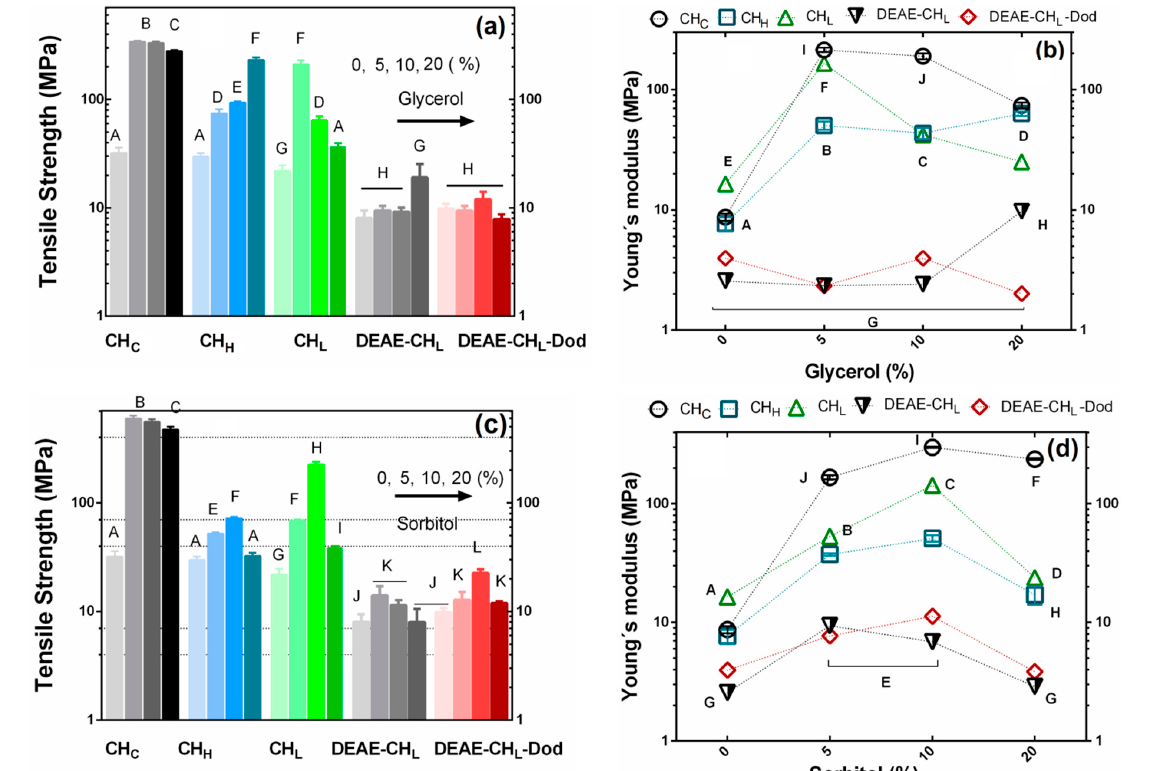
Figure 4. Tensile strength (TS) and Young’s modulus of chitosan films prepared with increasing concentrations of Glycerol ( a , b ) and Sorbitol ( c , d ). The values are expressed as means ± SD ( n = 5). Different letters indicate a significant difference ( p < 0.05).